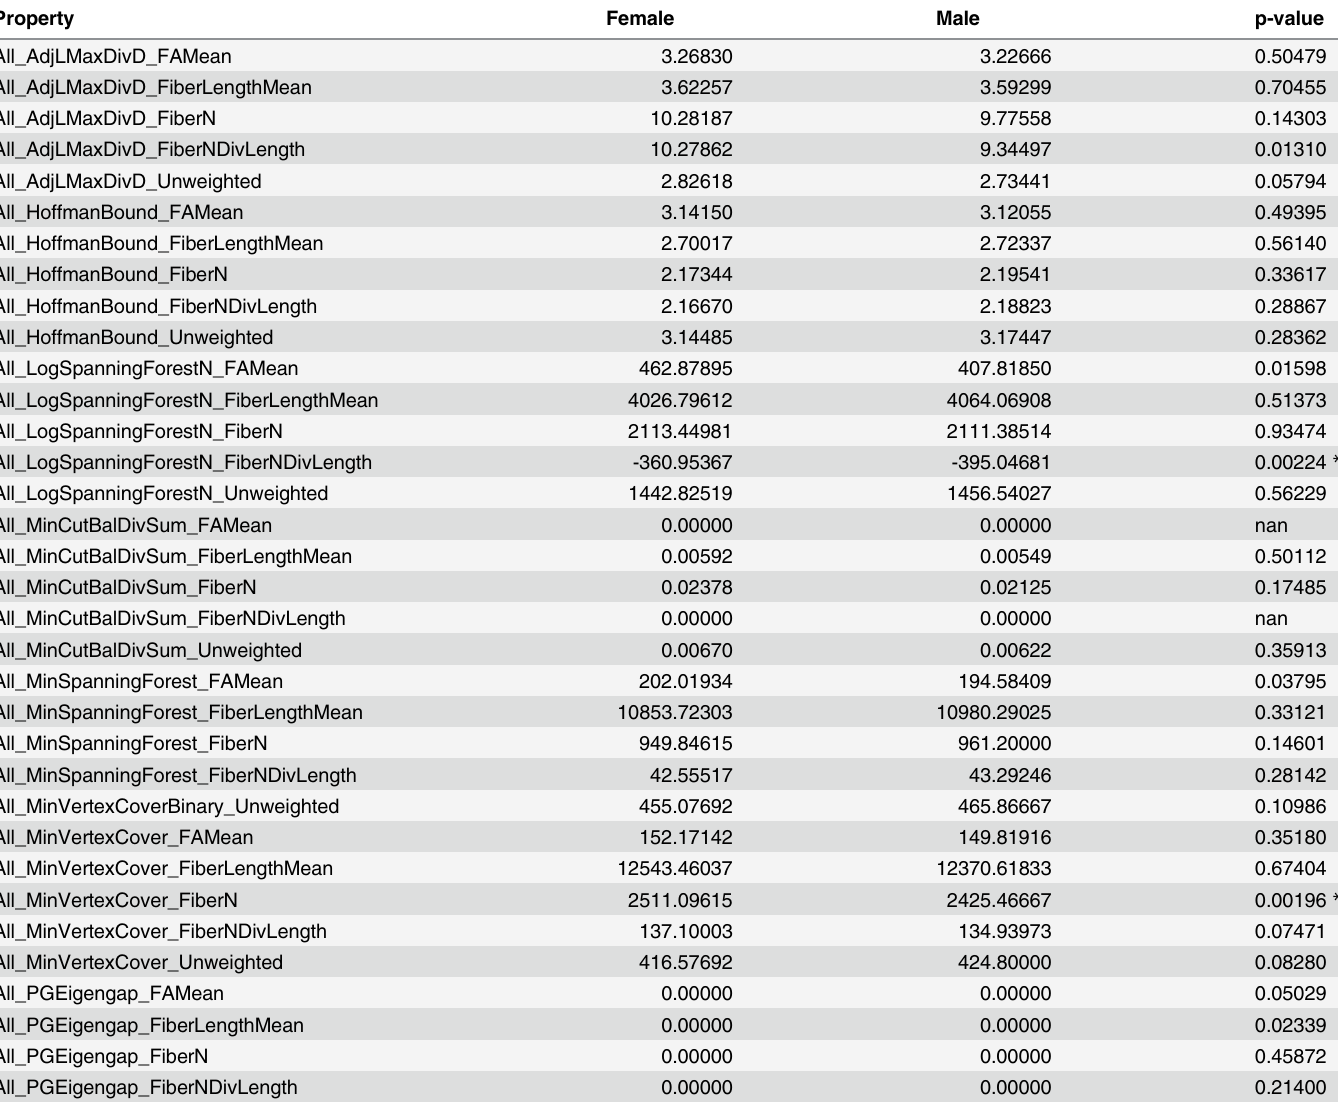
Table 6. The graph-theoretic parameters computed for the 1015-vertex graphs. The table contains their arithmetic means in the male and female groups, and the corresponding p-values in round 1 (see the “ Statistical analysis ” subsection). The results of the graph-parameters are defined in the caption of Table 1. Significant differences ( p < 0.01) are denoted with an asterisk in the last column.